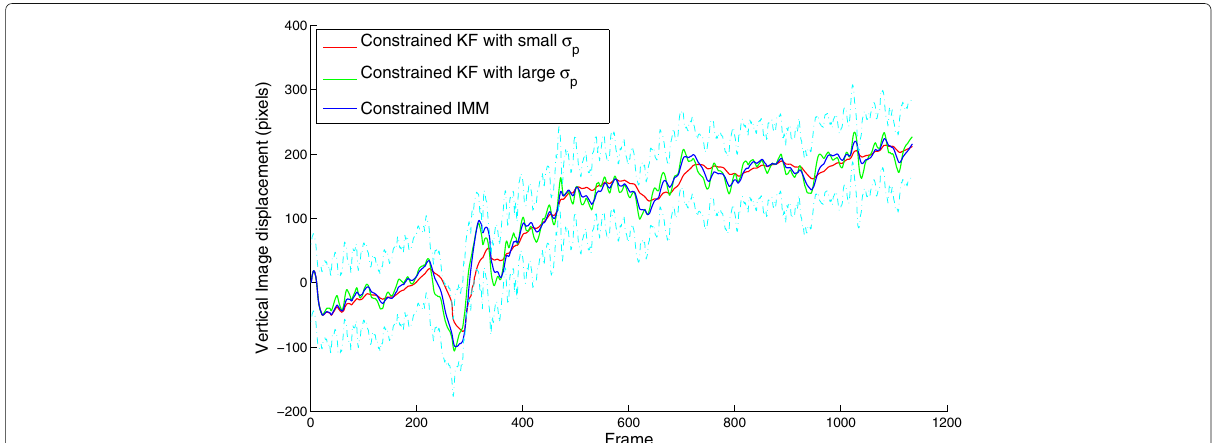
Fig. 10 Video 2 vertical motion: comparison between single-model constrained Kalman filtering and constrained IMM. Cyancurves are constraint boundaries